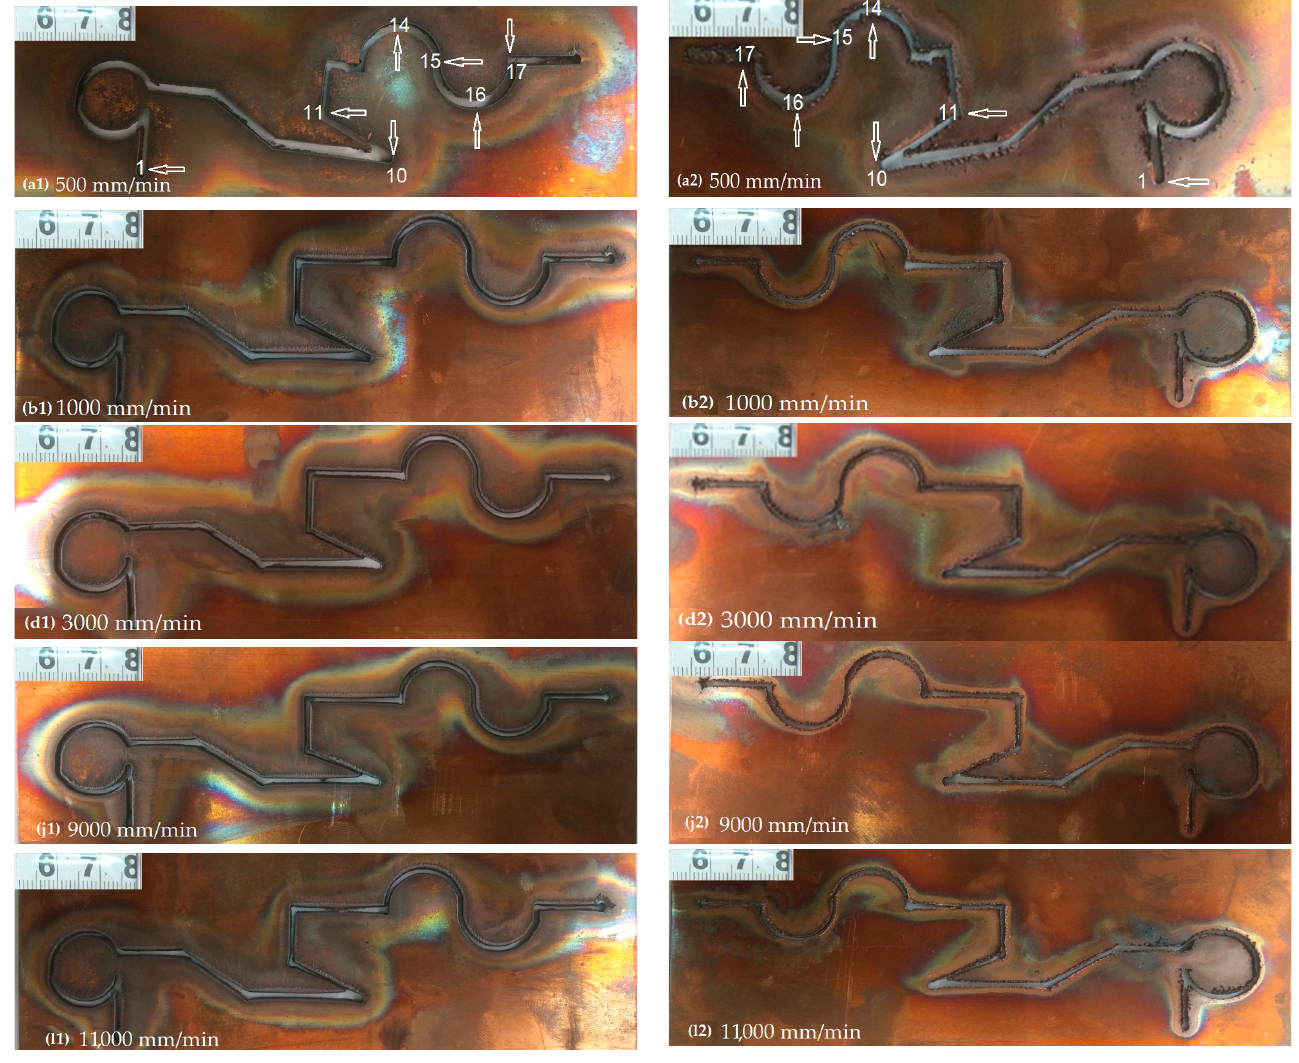
Figure 3. The cutting path width of experimental specimens after PC: ( a1 , a2 ); ( b1 , b2 ); ( d1 , d2 ); ( j1 , j2 ); ( l1 , l2 ) at 500, 1000, 3000, 9000, 11,000 mm/min at 30 A.